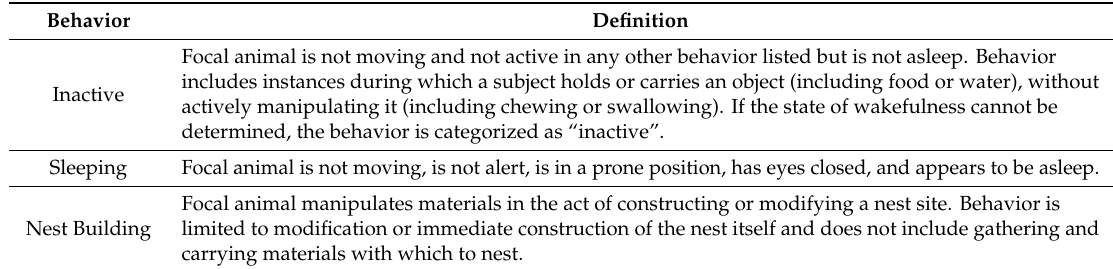
Table 1. The three “retirement” behaviors and their